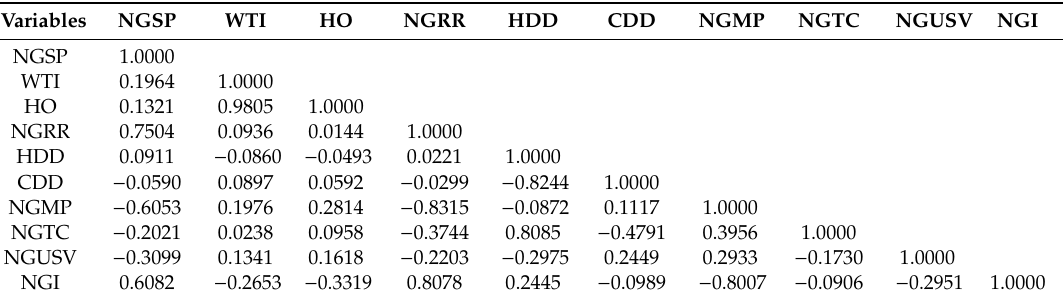
Table 3. Correlations between